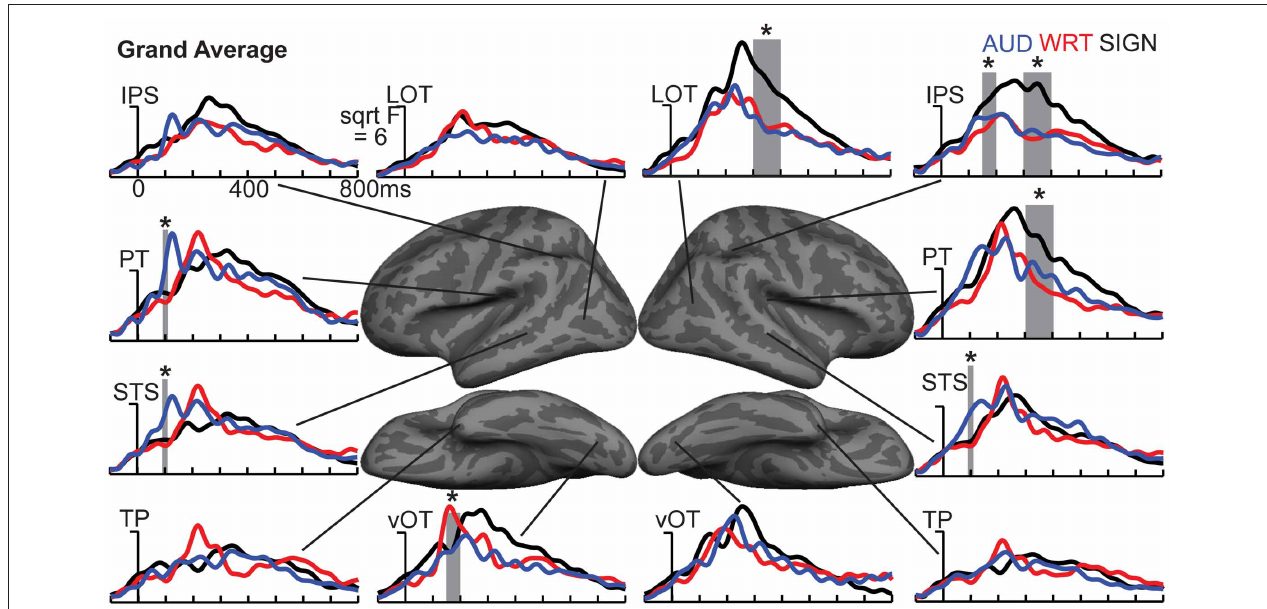
FIGURE 4 | ROI timecourses for the grand average across each language/modality. At 80–120ms in left PT, auditory words (blue lines) show a strong modality-specific peak. From 150 to 200ms, written words (red lines) show a word encoding peak in left vOT, and signed words (black lines) show a word encoding effect in right IPS. During a later time window from 300 to 400ms (thick gray bars), all conditions show